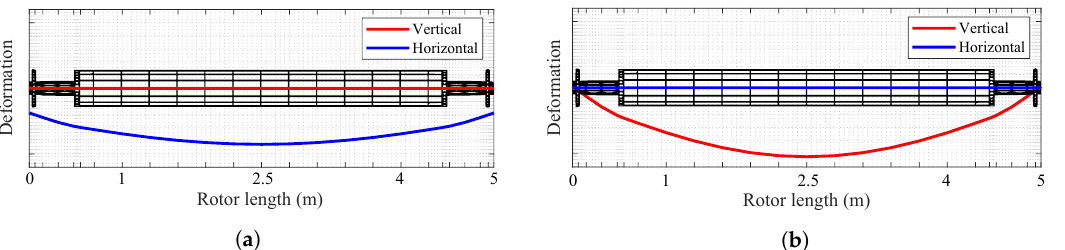
Figure 4. A sketch of the Paper machine’s steel tube roll with FE discretization. All dimensions are in meters.